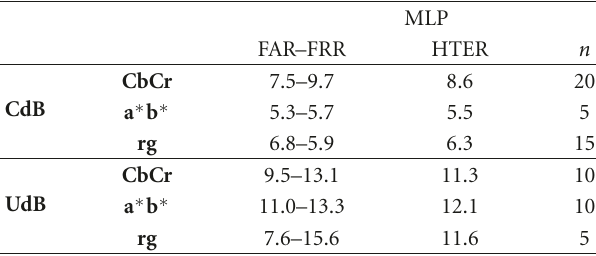
Table 3: HTER values for MLP at EER working